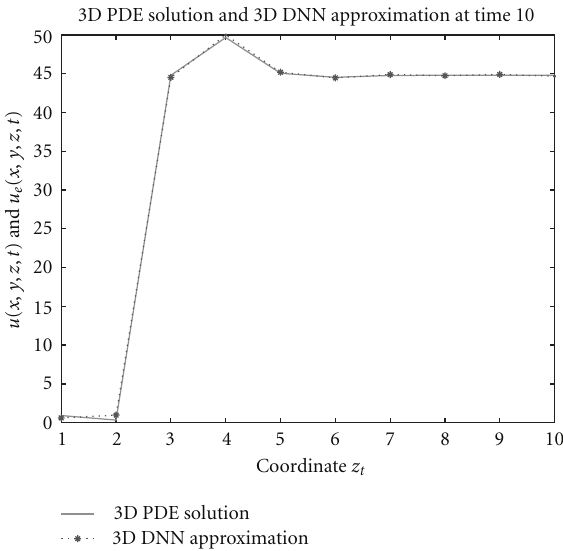
Figure 5: Comparison between 3D PDE trajectories and 3D DNN approximation for coordinate z at time 10s.